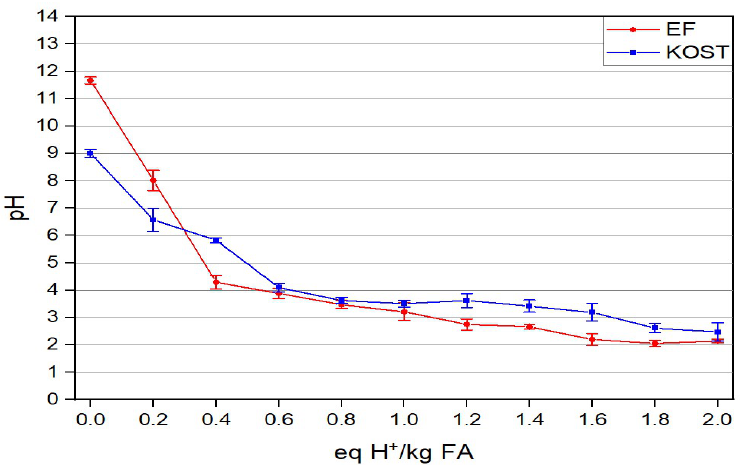
Figure 3. ANC test results of FA samples (EF and KOST).